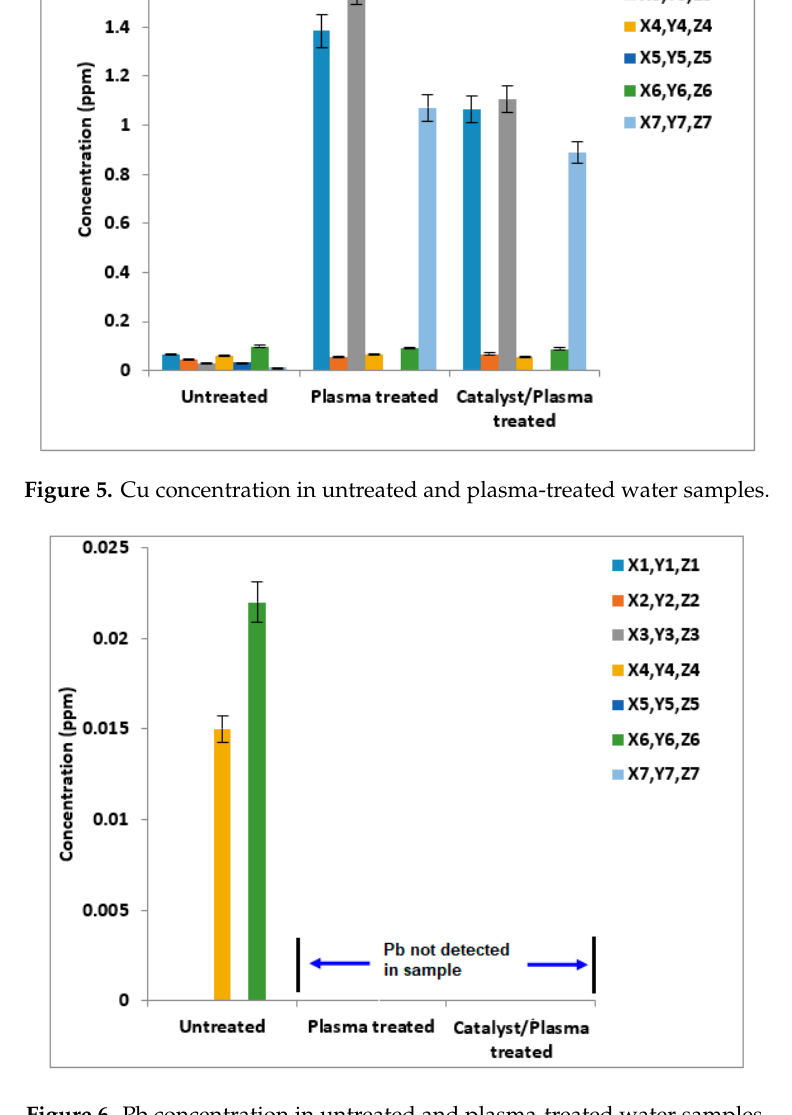
Figure 6. Pb concentration in untreated and plasma-treated water samples.